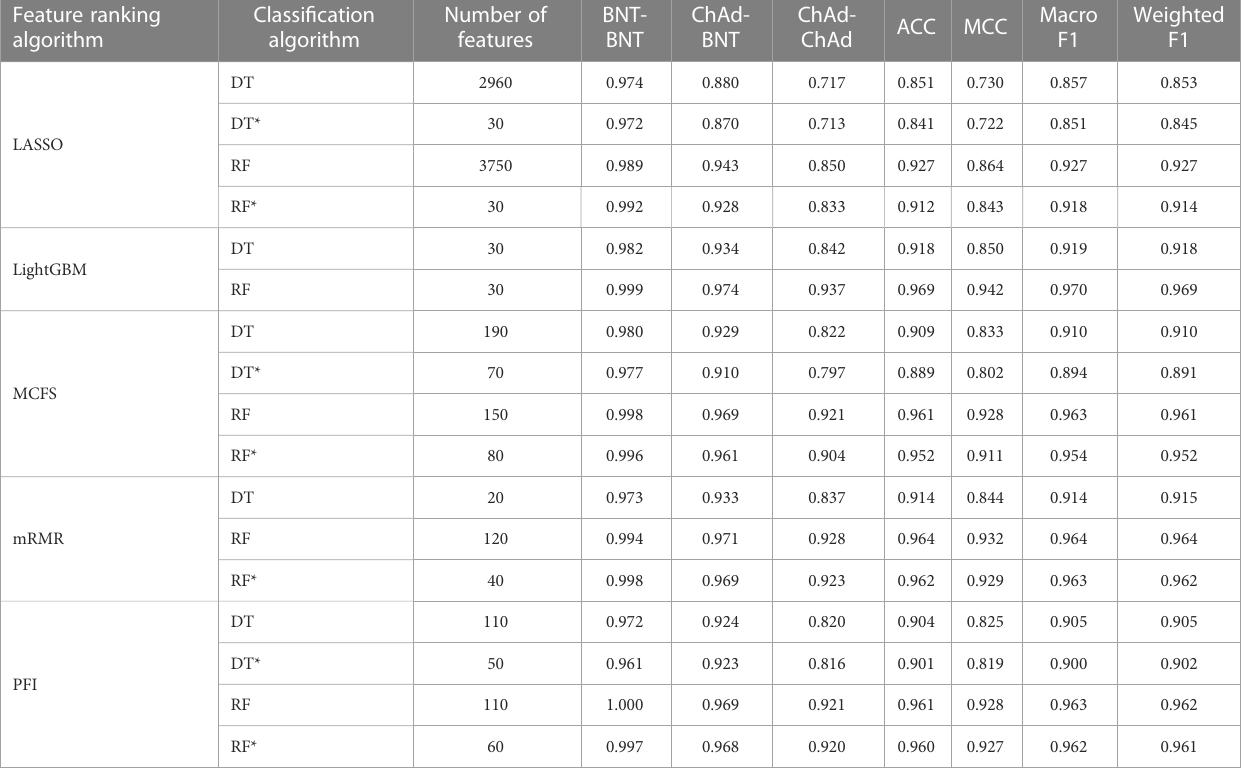
TABLE 2 Performance of key classi fi ers in B cell. Feature ranking